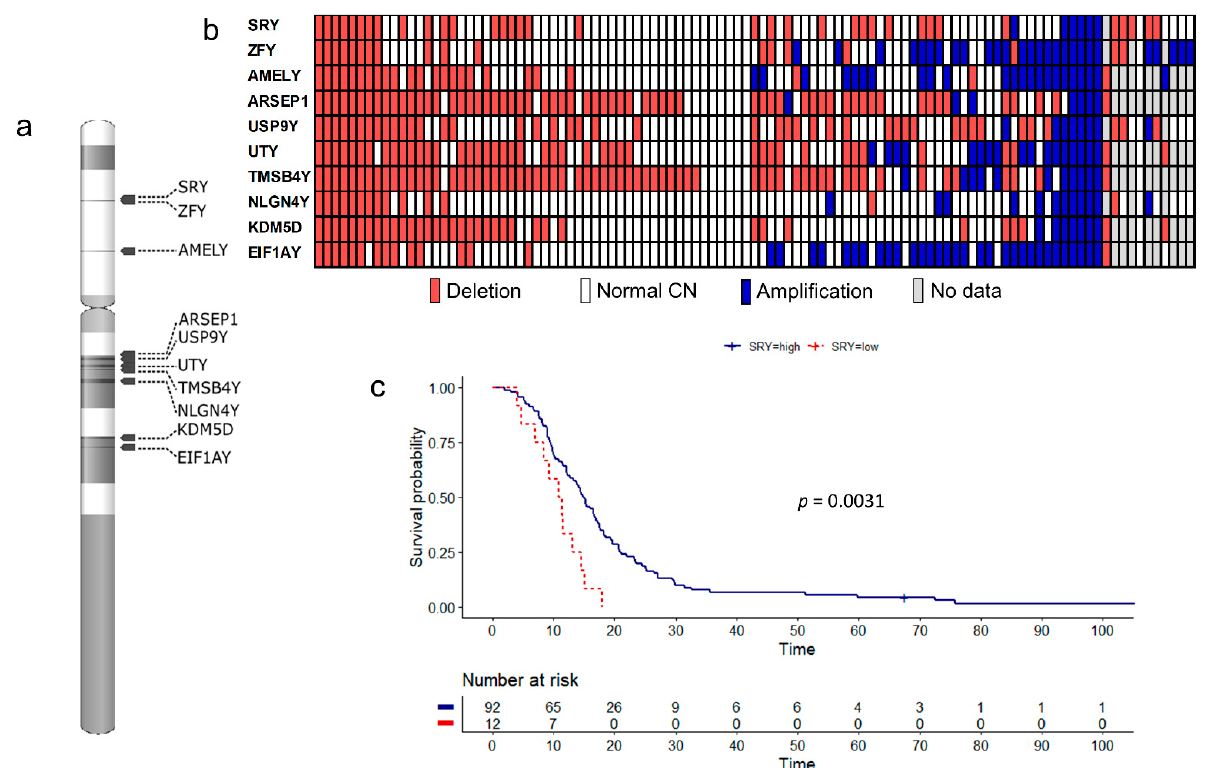
Figure 1. The ddPCR was used to test for copy number (CN) changes on chromosome Y, using 10 markers spread throughout both arms ( a ). We obtained CN results for all markers in 94 samples, detecting deletions (red; cut-off value 0.8), as well as amplifications (blue; cut-off value 1.2) ( b ). By applying maximally selected rank statistics analysis to the CN results (Supplementary Materials, Figure S1), we were able to choose the best deletion cut-off values, associated with shorter OS. Deletions of SRY ( c ) had significant association with shorter OS (10.8 vs. 14.8 months). For 11 samples results were not obtained for one or more genes.